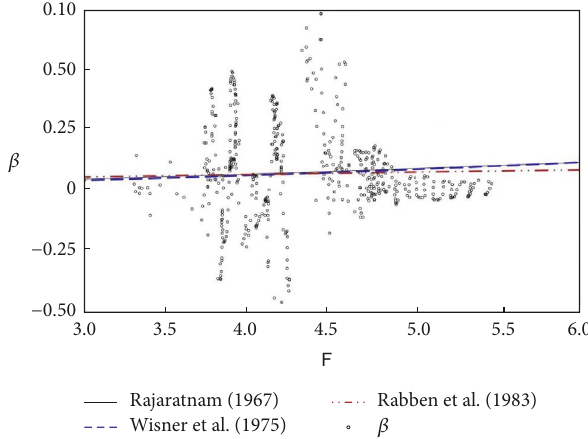
Figure 12: The change of 𝛽 as function of F